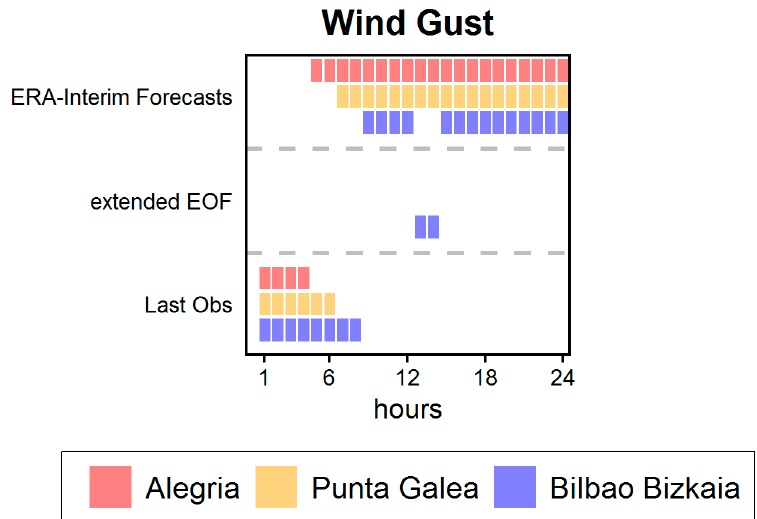
Figure 10. Most important input (last observation, extended empirical orthogonal functions (extEOFs), or ERA-Interim forecast) for the wind gust for the next 24 h, at three locations (Bilbao Bizkaia, Punta Galea, and Alegria), and using the RF method.